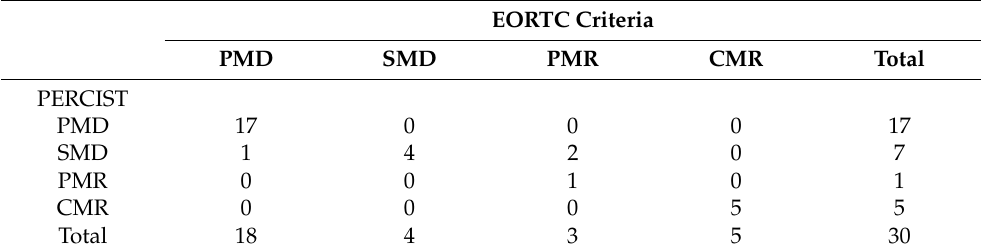
Table 2. Comparison of treatment response assessments in EORTC criteria and